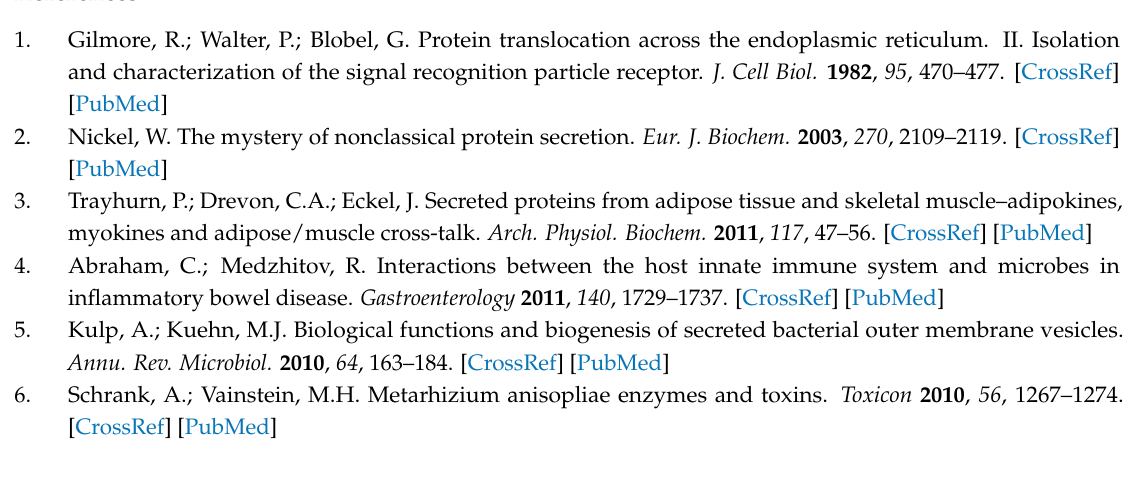
Table S1: The selected 20 motifs in six datasets. Table S2: Physicochemical index data for twenty standard amino acids. Table S3: Performance of different numbers of features in six training datasets over five-fold cross-validation. Table S4: The predicted scores for all unreviewed human proteome by iMSP. Table S5: The predicted scores for potential SPs with highest probabilities by iMSP. Figure S1 Feature ranking in six training